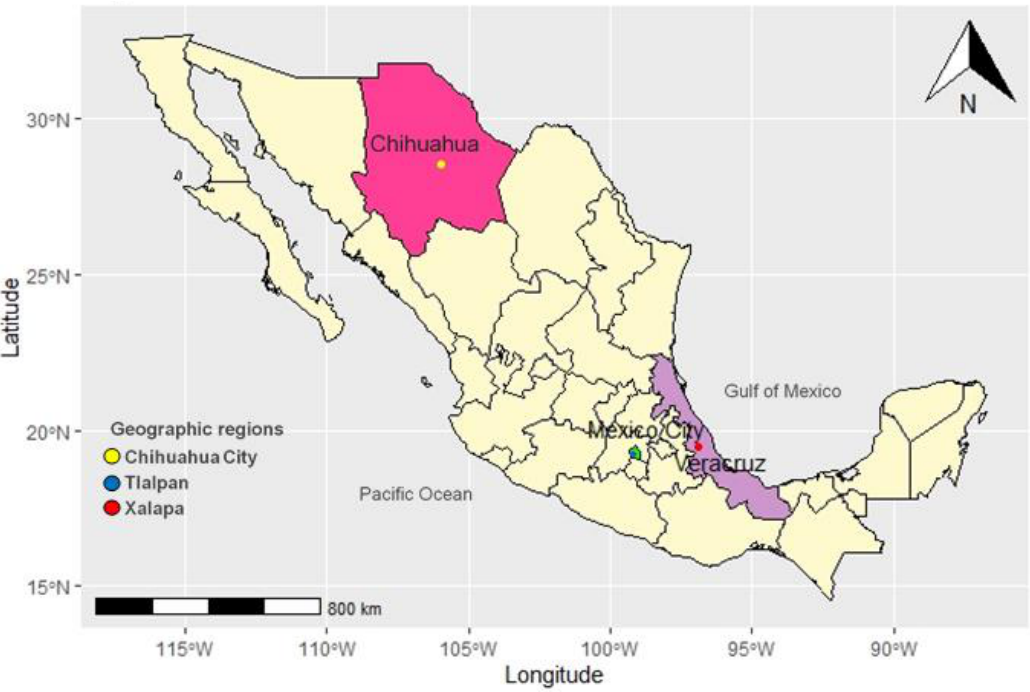
Figure 1. Geographical representation of Mexico showing the location of included populations. Chihuahua City (yellow point), located at the State of Chihuahua; Tlalpan (blue point), located at Mexico City, and Xalapa (red point), located at the State of Veracruz.